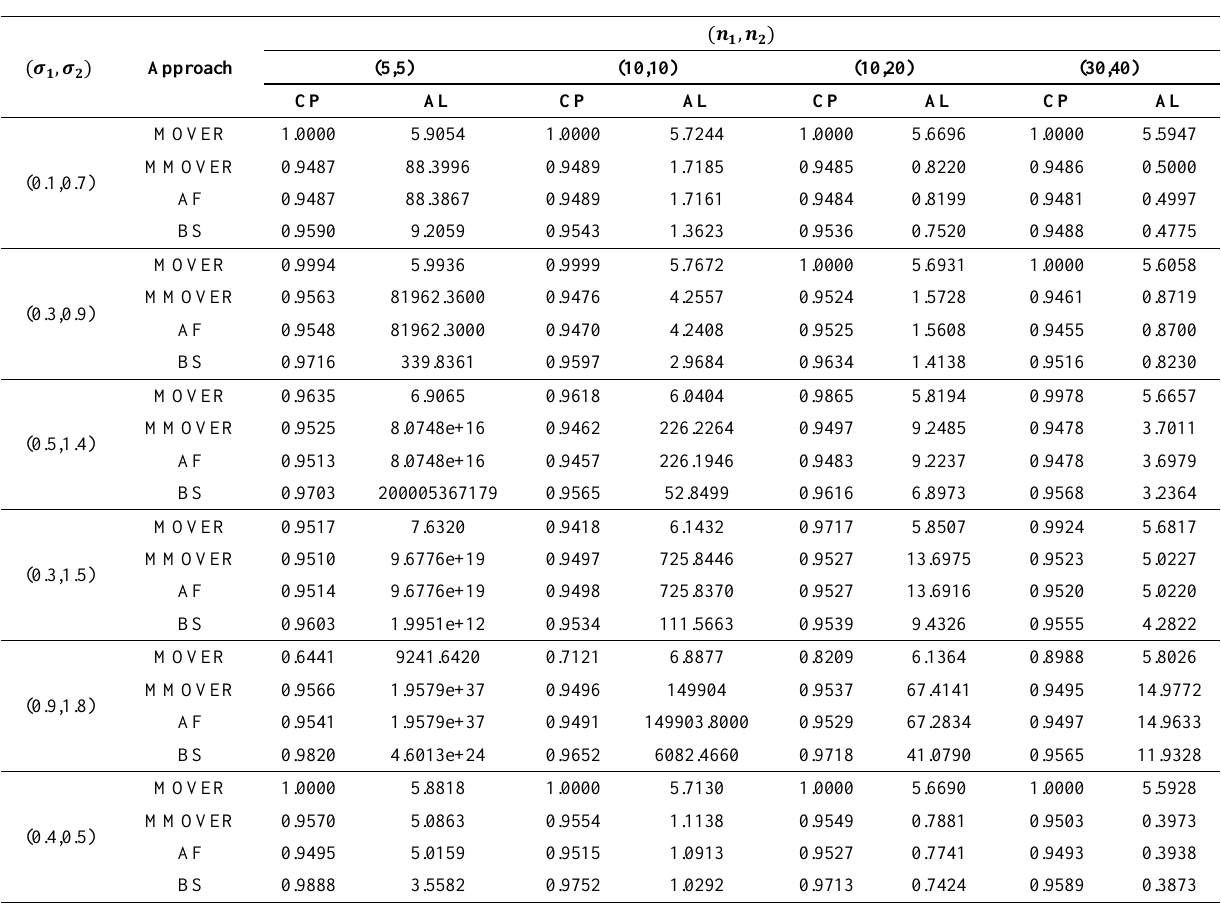
Table 3. The CP and AL of 95% two-sided confidence intervals for difference between the coefficients of variation of log- normal distributions as function of sample sizes.